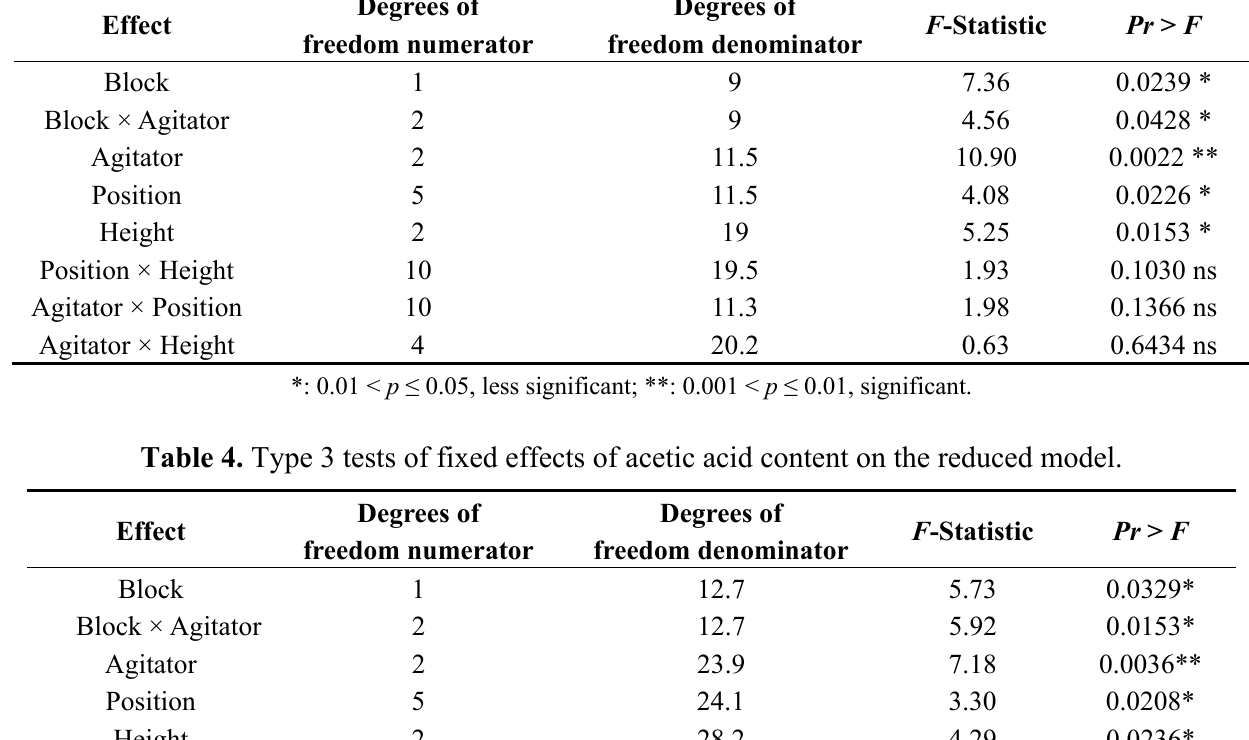
Table 3. Type 3 tests of the fixed effects of acetic acid content on the full model alpha = 5%. Degrees of Degrees of F -Statistic Pr > F Effect freedom numerator freedom denominator Block 1